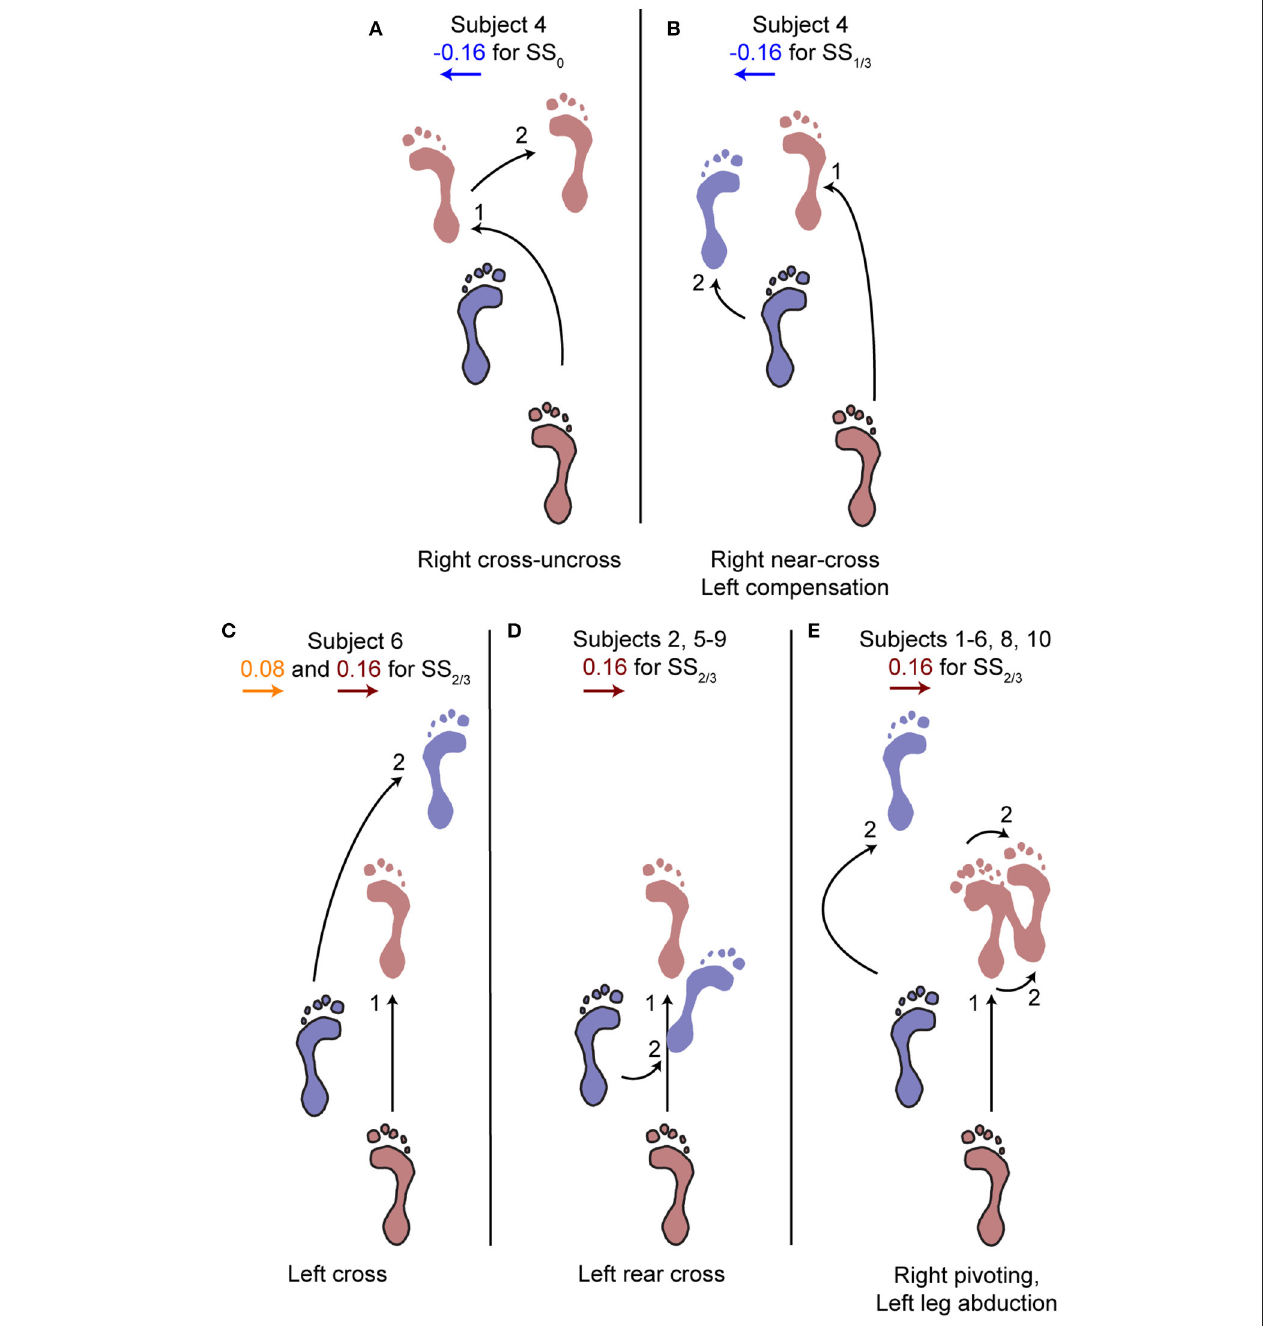
FIGURE 5 | Alternative stepping strategies. Alternative strategies used by one or multiple subjects for specific perturbations. The number (1, 2) corresponds to the step number in Figure 4 . (A) Cross-uncross, making a double step with the right leg. (B) Near-cross step with the right leg, followed by a short left step to prevent the body from falling leftward. (C) Left cross-step. (D) Rear cross-step. (E) Foot pivoting, by first rotating about the toes, then shifting the COP back toward the heel and rotating about the heel. Accompanied by left leg abduction during the swing to prevent toppling over the right stance leg. Several subjects showed both (D,E) throughout the repetitions of the 0.16 perturbations at SS 2 / 3